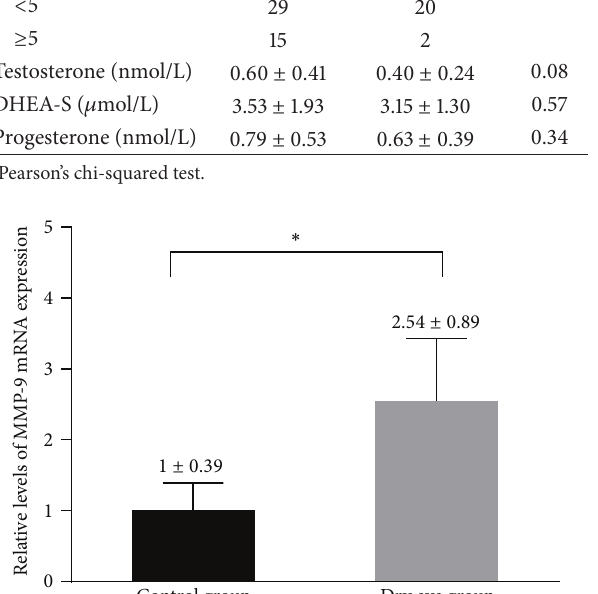
Figure 1: Real-time PCR results of relative levels of MMP-9 mRNA expression in conjunctival cytology samples obtained from patients with dry eye and normal controls. Values were presented as mean ± SD. ∗ Significant difference with 𝑃 < 0.05